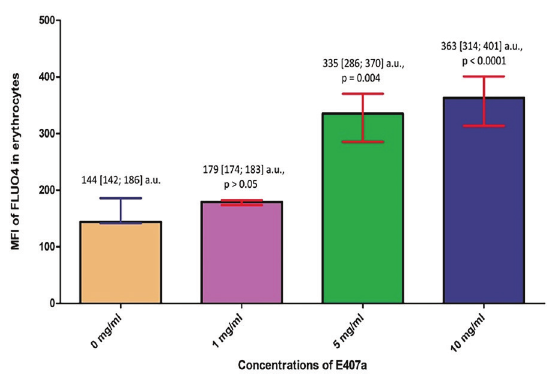
Figure 3 - Mean fluorescence intensity (MFI) values of FLUO4 in red blood cells treated with semi-refined carrageenan (E407a) reflect the intracellular calcium ion levels